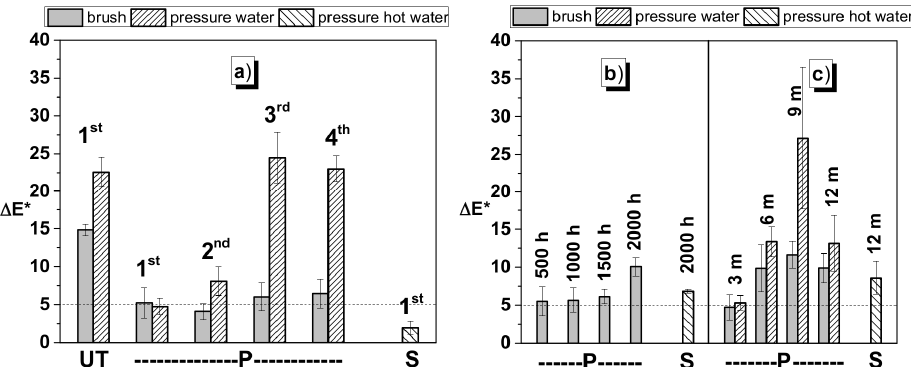
Figure 7. Colour changes on the surface of anti ‐ graffiti ‐ coated concrete after graffiti removal on the originally painted areas: ( a ) before weathering, ( b ) after artificial and ( c ) after natural weathering. P, permanent anti ‐ graffiti coating; S, sacrificial coating; UT, without anti ‐ graffiti.